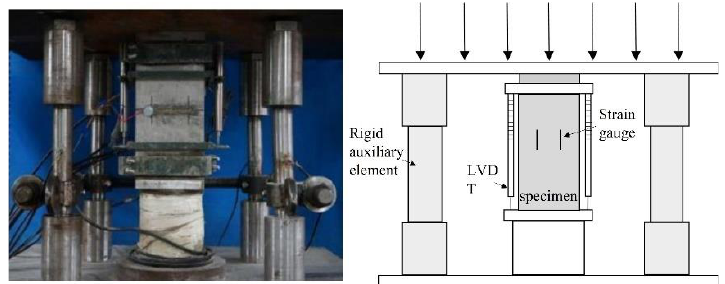
Figure 3. Uniaxial compression test device.